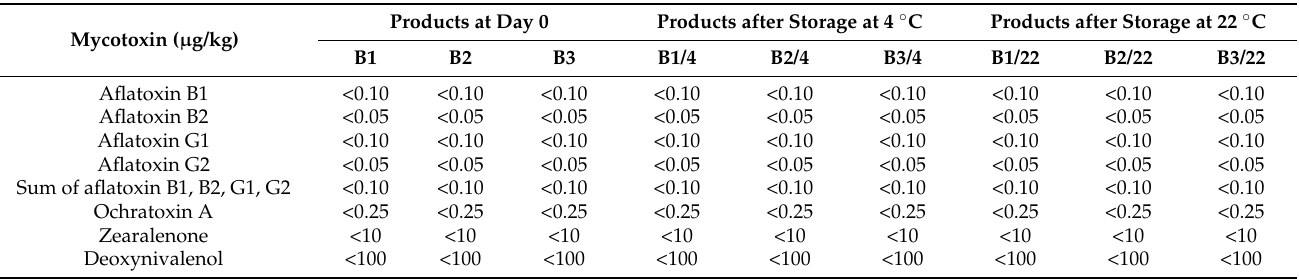
Table 3. Presence of selected mycotoxins in HPB bars immediately after production (time 0) and after 3 months of storage at 4 ◦ C and 22 ◦ C ( n =